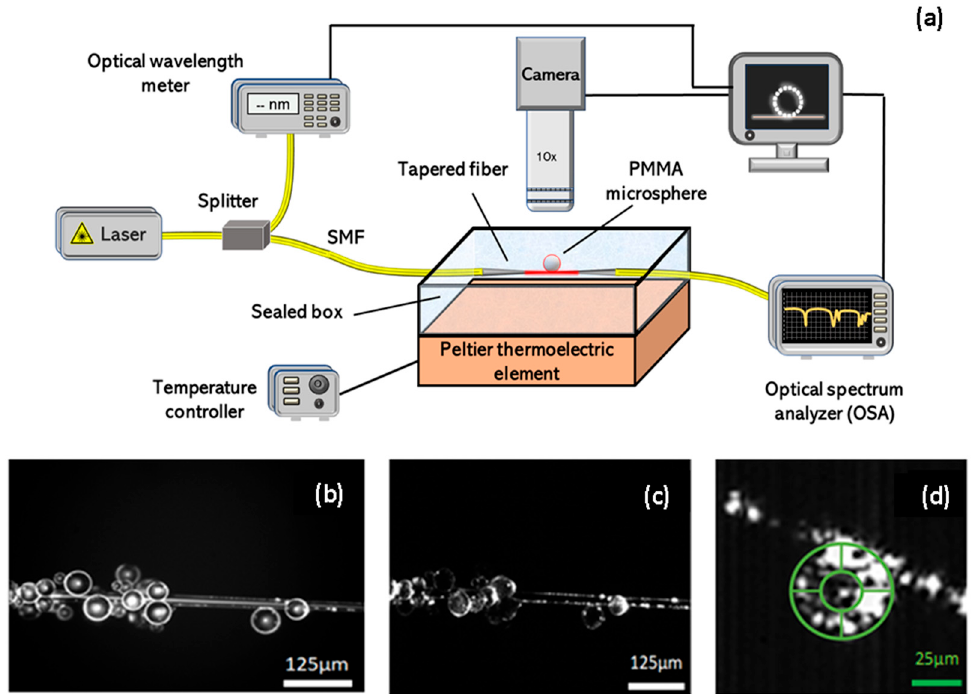
Figure 1. ( a ) Scheme of the experimental setup for PMMA microsphere characterization. WGMs and circulating light in the microspheres were observed with a camera through the sealed humidity and dust prevention box roof. ( b ) Microscope image of various size PMMA microspheres attached to a tapered fiber taken with the visible light camera and additional visible illumination. ( c ) The same place observed with a NIR camera when only NIR laser radiation was propagating through the tapered fiber. Due to surface imperfections of the microspheres, we could record light intensity on the outer layer of each sphere where circulating light was scattered and leaked out of the microspheres. ( d ) Close-up of one PMMA microsphere (taken with a NIR camera) when WGMs are present. Green lines indicate the division of the microsphere image into smaller sections.